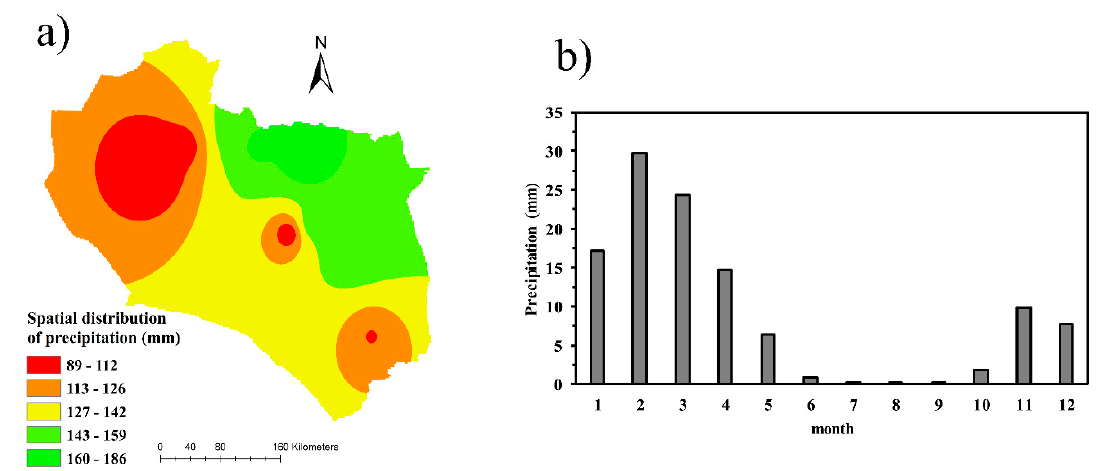
Figure 2. Spatial ( a ) and temporal ( b ) distribution of annual rainfall in South